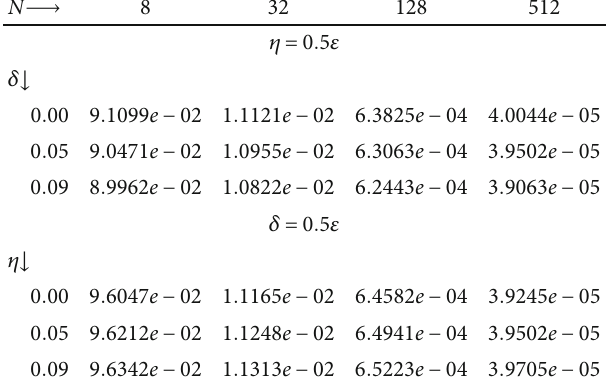
Table 4: Maximum absolute error of Example 7 for ε = 0 : 1 . N